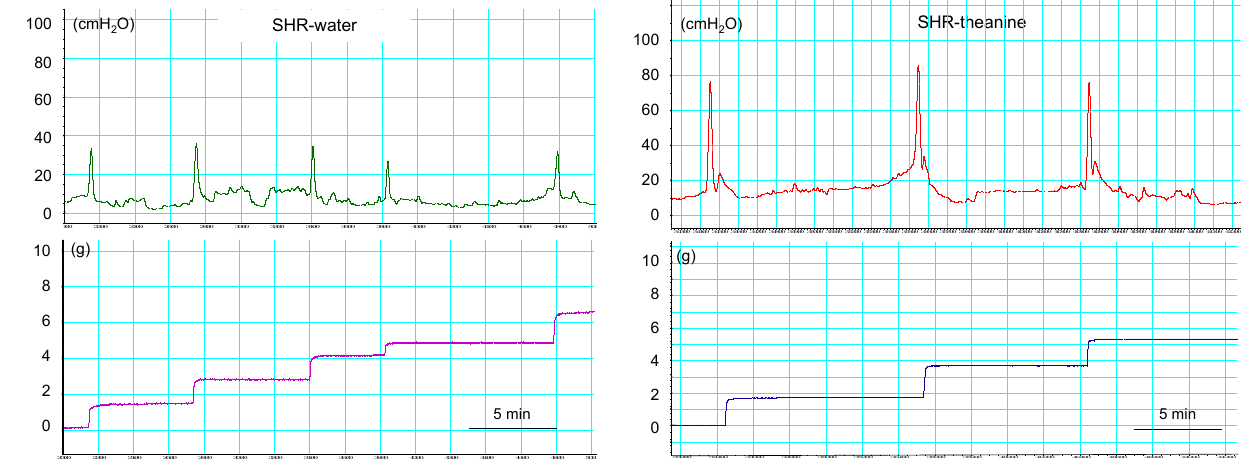
Figure 3. Typical cystometrograms in the SHR–water and SHR–theanine groups. Micturition interval is significantly longer, and voided volume is significantly larger in the SHR-theanine group than in the SHR–water group. Scale bars = 5 min.